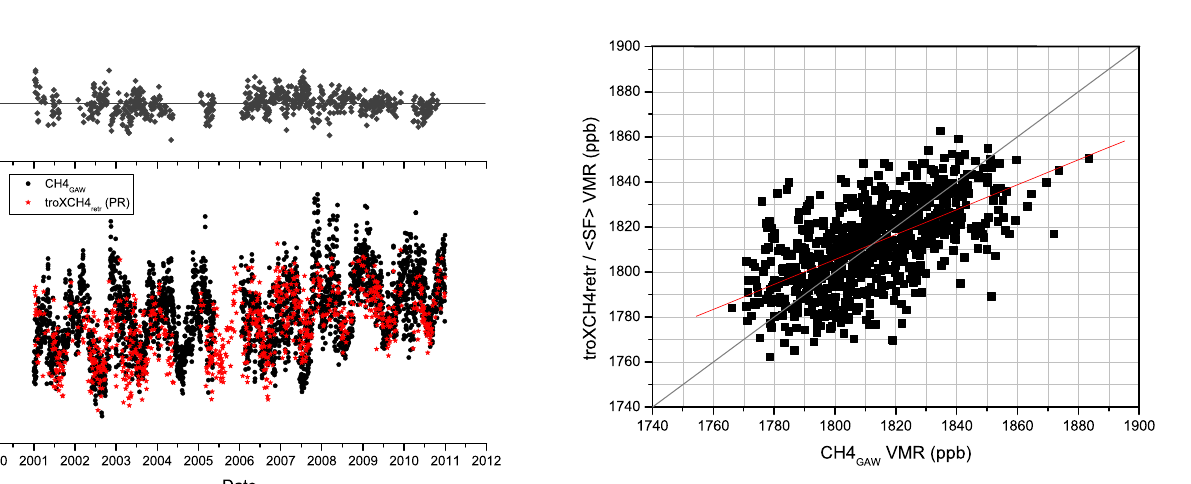
Fig. 10. CH 4 in-situ versus troXCH 4 / < SF > correlation plot. retr GAW < SF > is the mean scaling factor between both quantities. The red line shows the linear regression line, while the grey one shows the diagonal as a